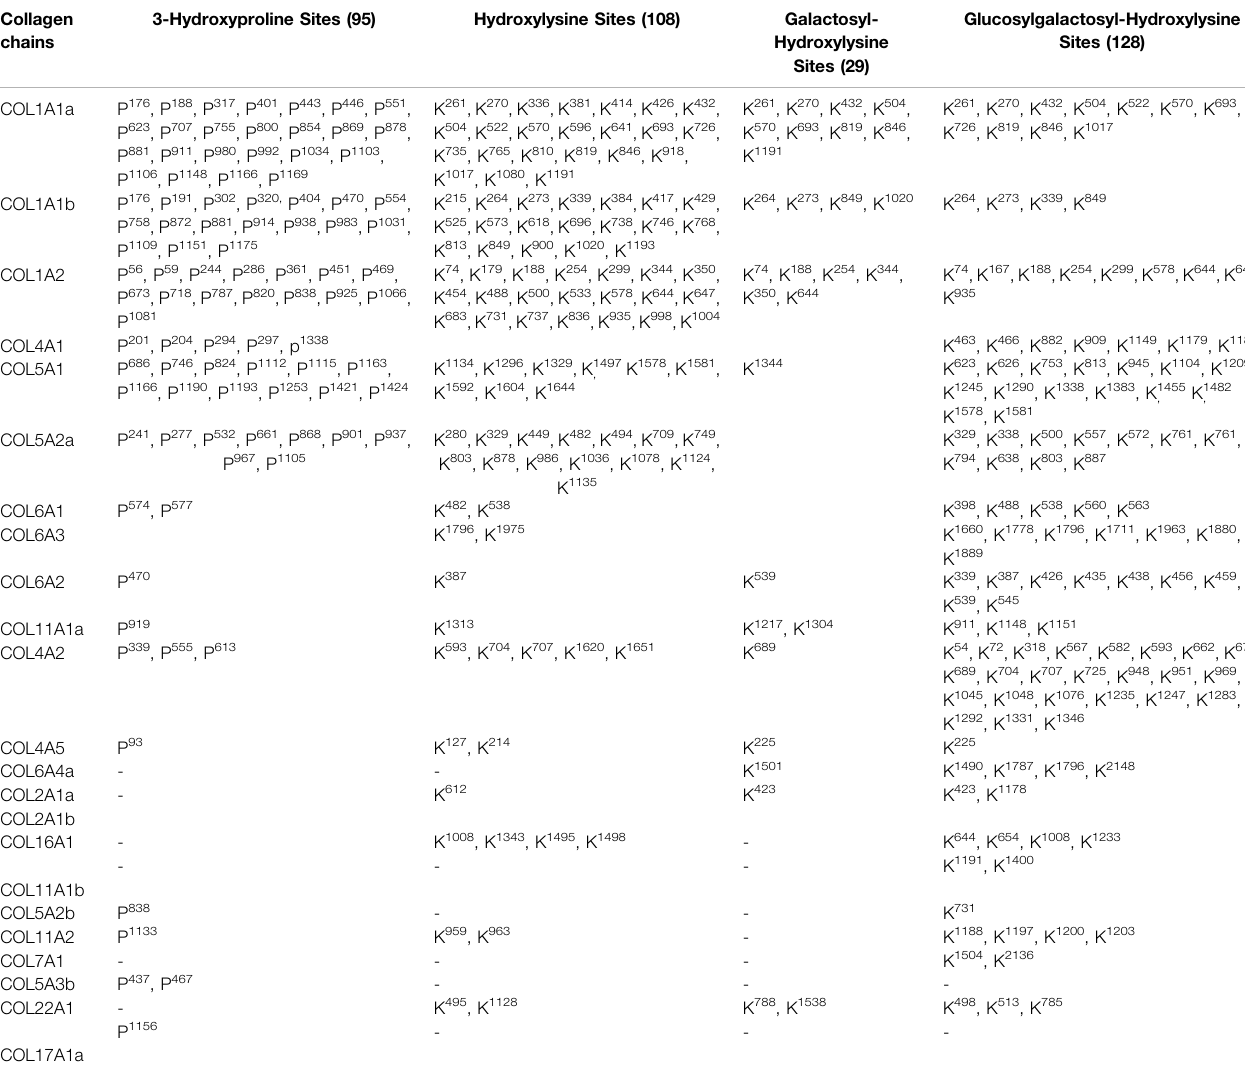
TABLE 1 | Mass-Spectrometry-based identi fi cation of site-speci fi c hydroxylation and glycosylation of different collagens present in the zebra fi sh cardiac ECM. Collagen 3-Hydroxyproline Sites (95) Hydroxylysine Sites (108) Galactosyl- chains